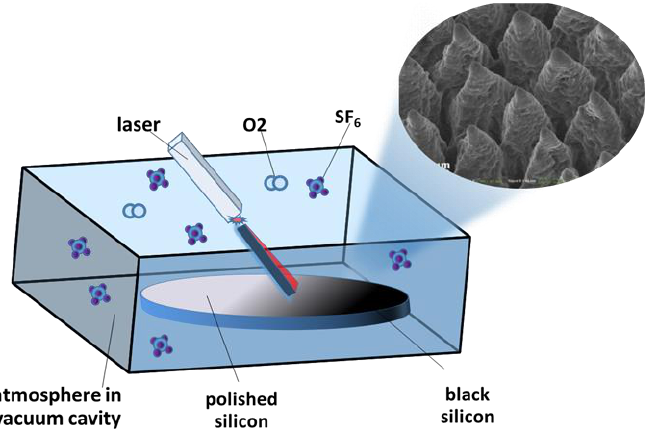
Figure 3. The fabrication principle of black silicon using femtosecond/nanosecond laser irradiation. Adapted from reference [37], with permission from Elsevier © 2020.